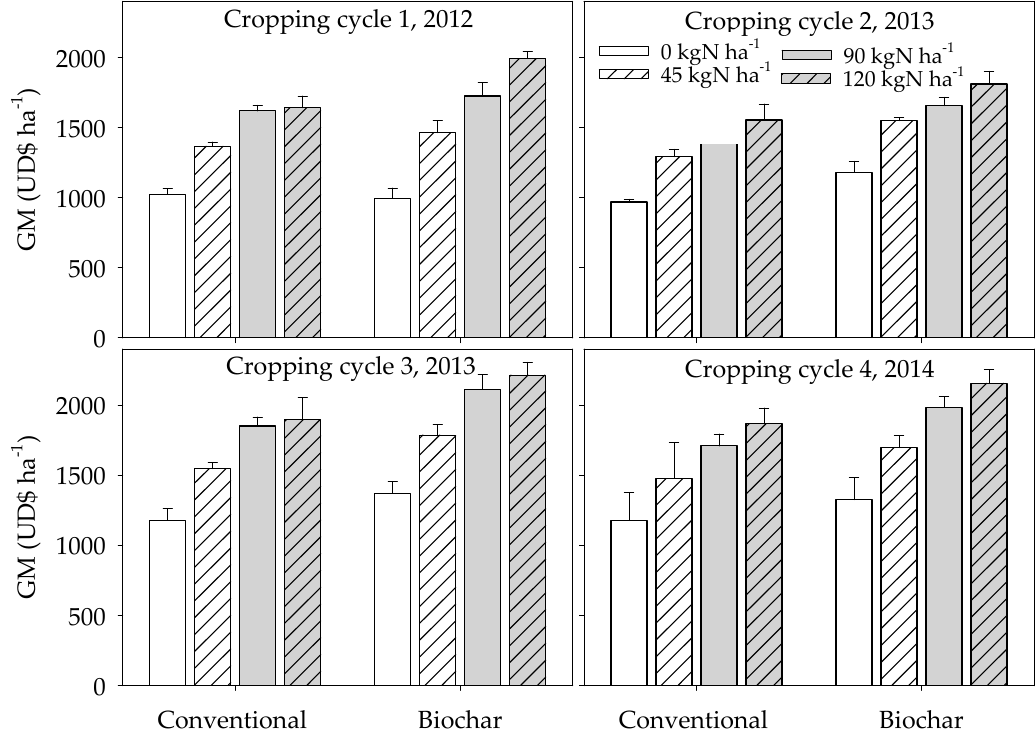
Figure 5. Gross margins (GM) of biochar (10 t · ha − 1 ) and nitrogen fertilizer (kg · ha − 1 ) used in irrigated rice over 4 cropping cycles (2012–2014) at Kpong, Ghana. Error bars are standard deviations of the means. The 1st and 3rd cropping cycles were from July to November while the 2nd and 4th cropping cycles spanned the period December to April.